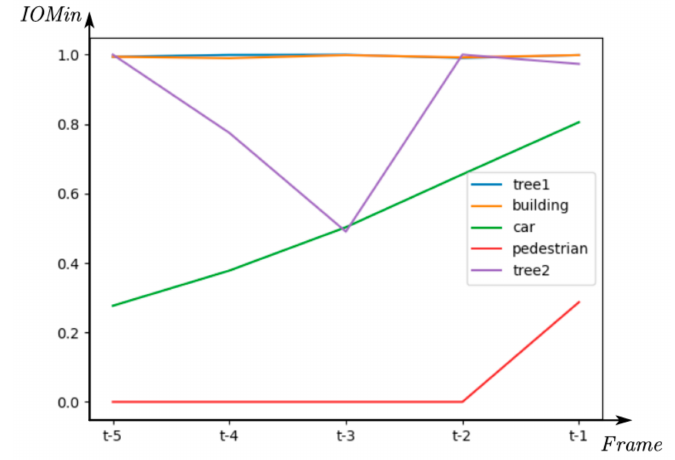
Figure 14. The intersection over minimum volume ( IOMin ) of di ff erent objects in the current frame and the first five frames,